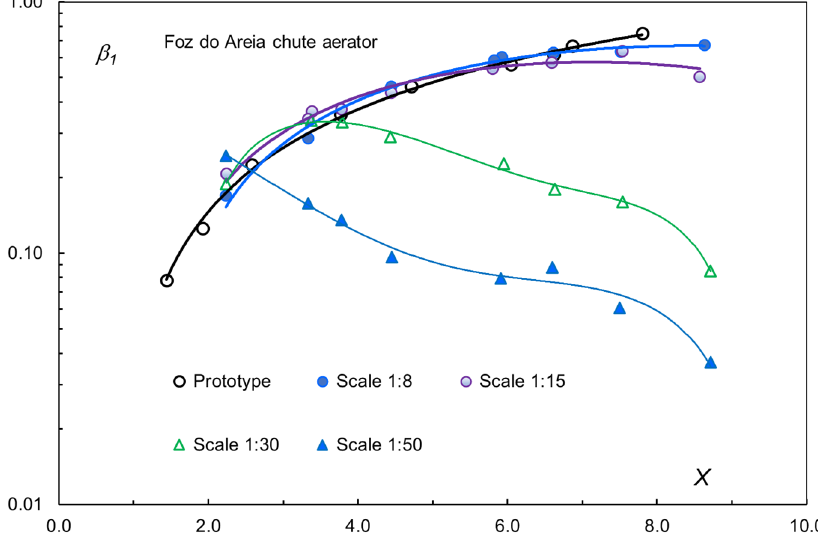
Figure 12. Model–prototype comparisons of air demand ( β 1 ‐ X ) for Foz do Areia spillway aerator (based on the data in [22]).